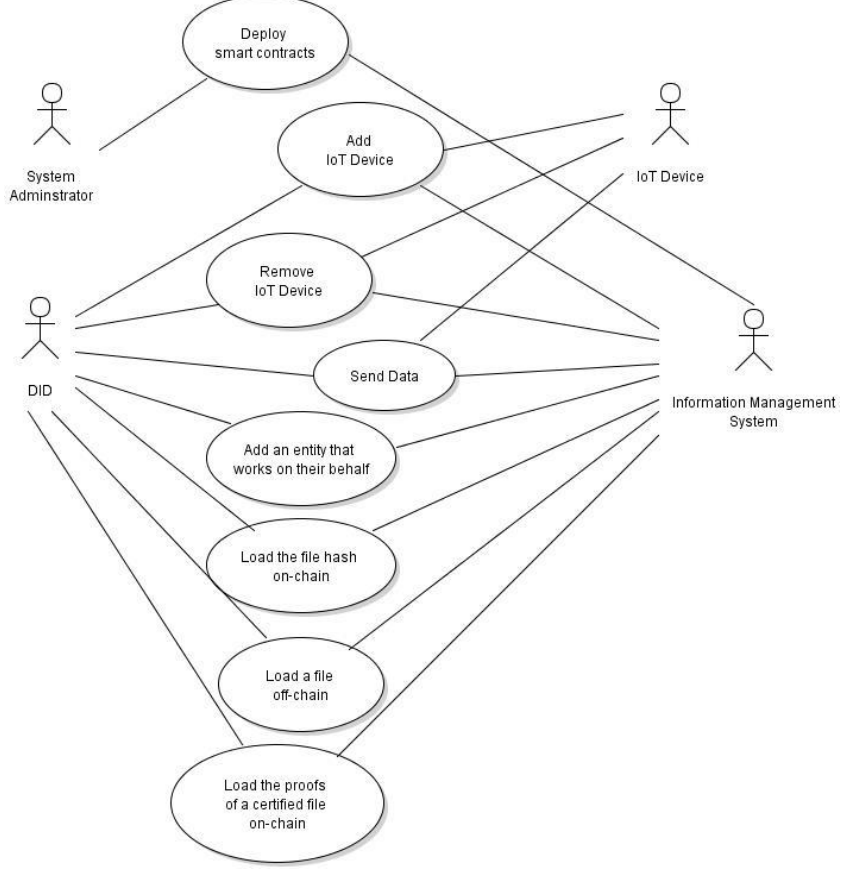
Figure 3. Format for Verifiable ID and Attestation signed with a DID Key.